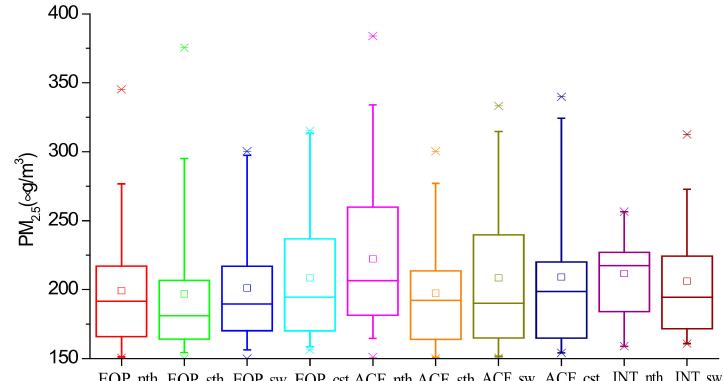
Figure 4. PM 2.5 concentration distributions of RPHPDs under the ten types. Rectangle: